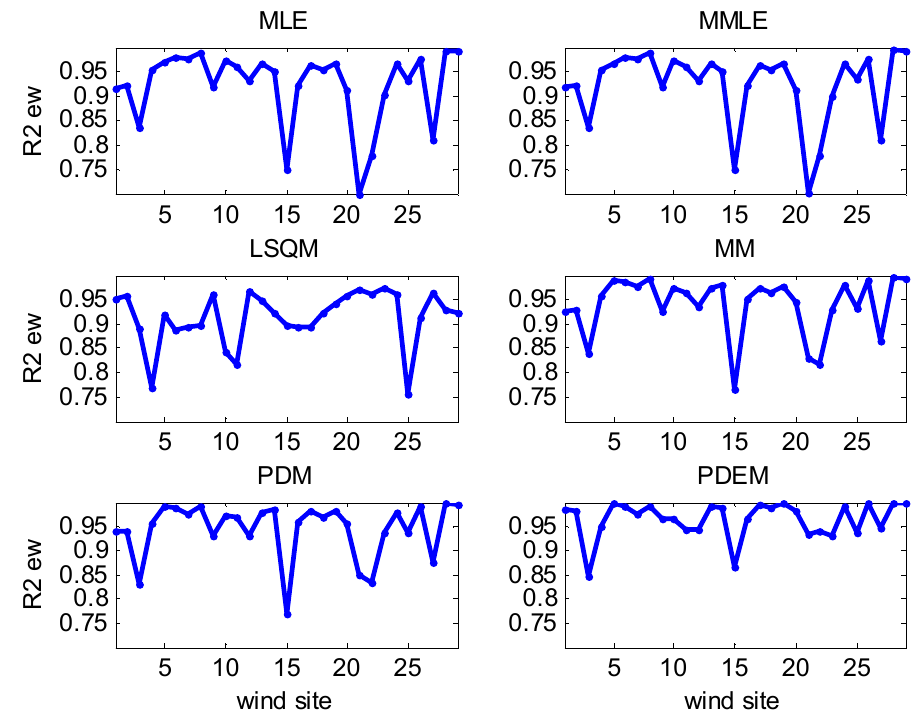
R at the different wind sites ew